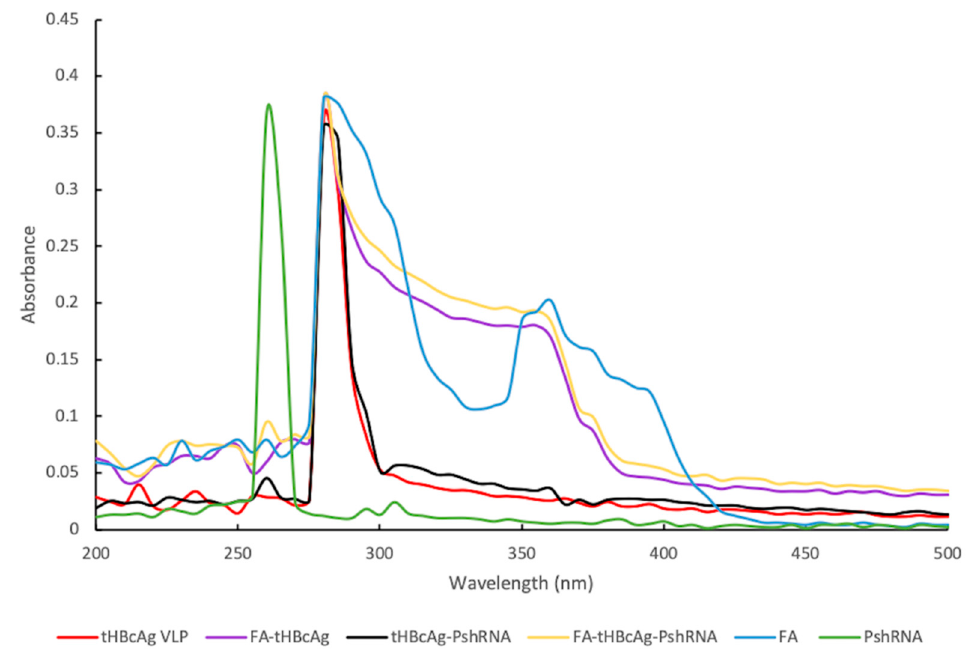
Figure 4. Spectrophotometric analysis of folic acid (FA) conjugated to tHBcAg VLPs. Spectra of tHBcAg (truncated hepatitis B core antigen), FA-tHBcAg (truncated hepatitis B core antigen conjugated with folic acid), tHBcAg-PshRNA (PshRNA packaged with truncated hepatitis B core antigen), FA-tHBcAg-PshRNA (PshRNA packaged with truncated hepatitis B core antigen and conjugated with folic acid), FA (folic acid) and PshRNA (plasmid synthesizing short hairpin RNA). A higher absorbance reading at 360 nm was observed in FA-tHBcAg, FA-tHBcAg-PshRNA, and FA samples, suggesting that FA was successfully conjugated to tHBcAg VLP.